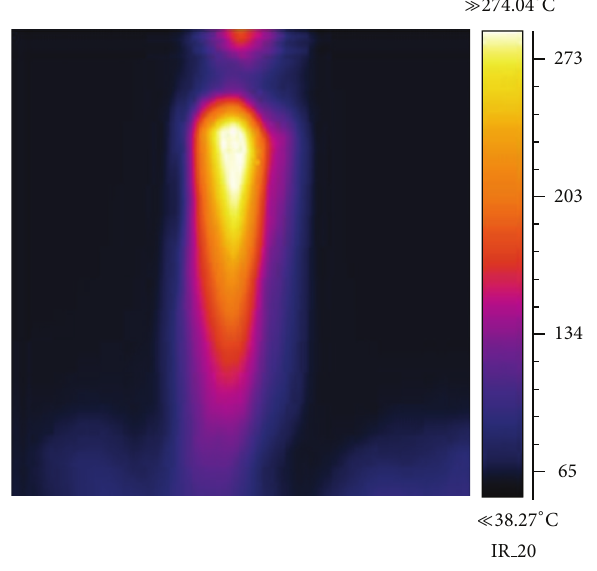
Figure 6: Thermal image of the ROI at 𝑡 = 85 sec.